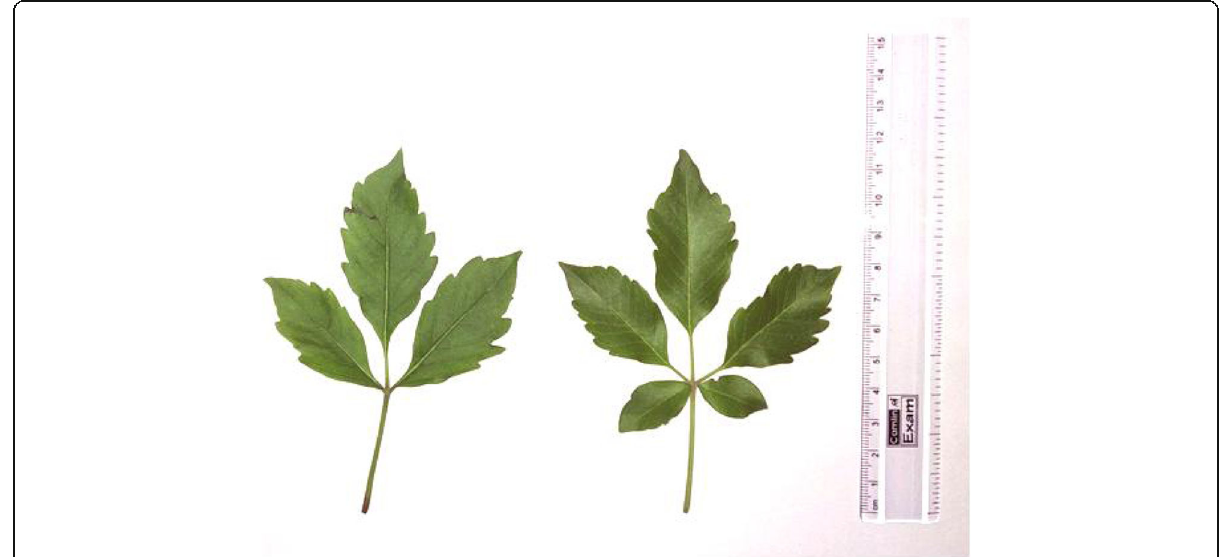
Fig. 2 Vitex negundo leaves